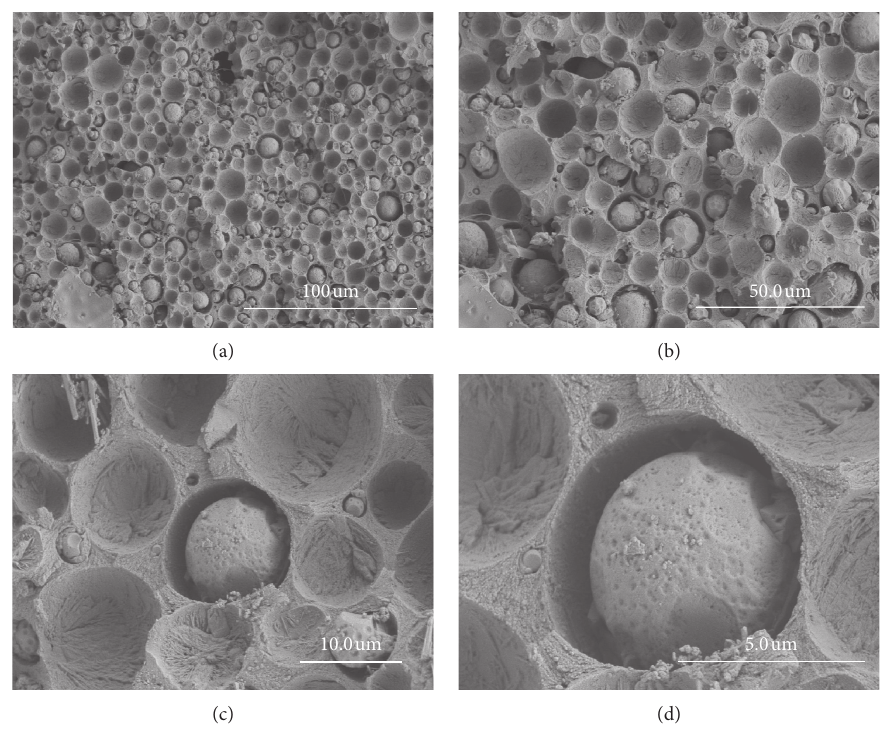
Figure 5: SEM images of the C7-1% sample: (a) 500 x , (b) 1000 x , (c) 3000 x , and (d) 6000 x